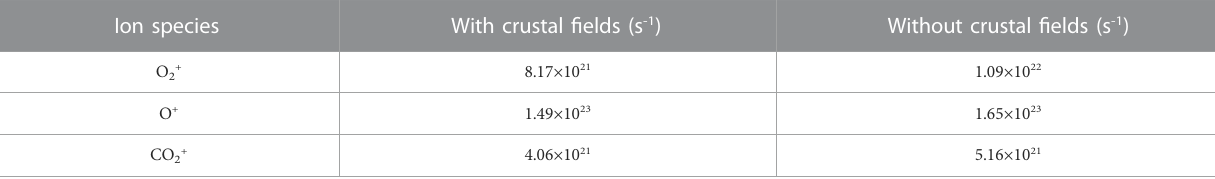
TABLE 1 The global loss rates of O 2 + , O + , and CO 2 + in cases with and without crustal fi